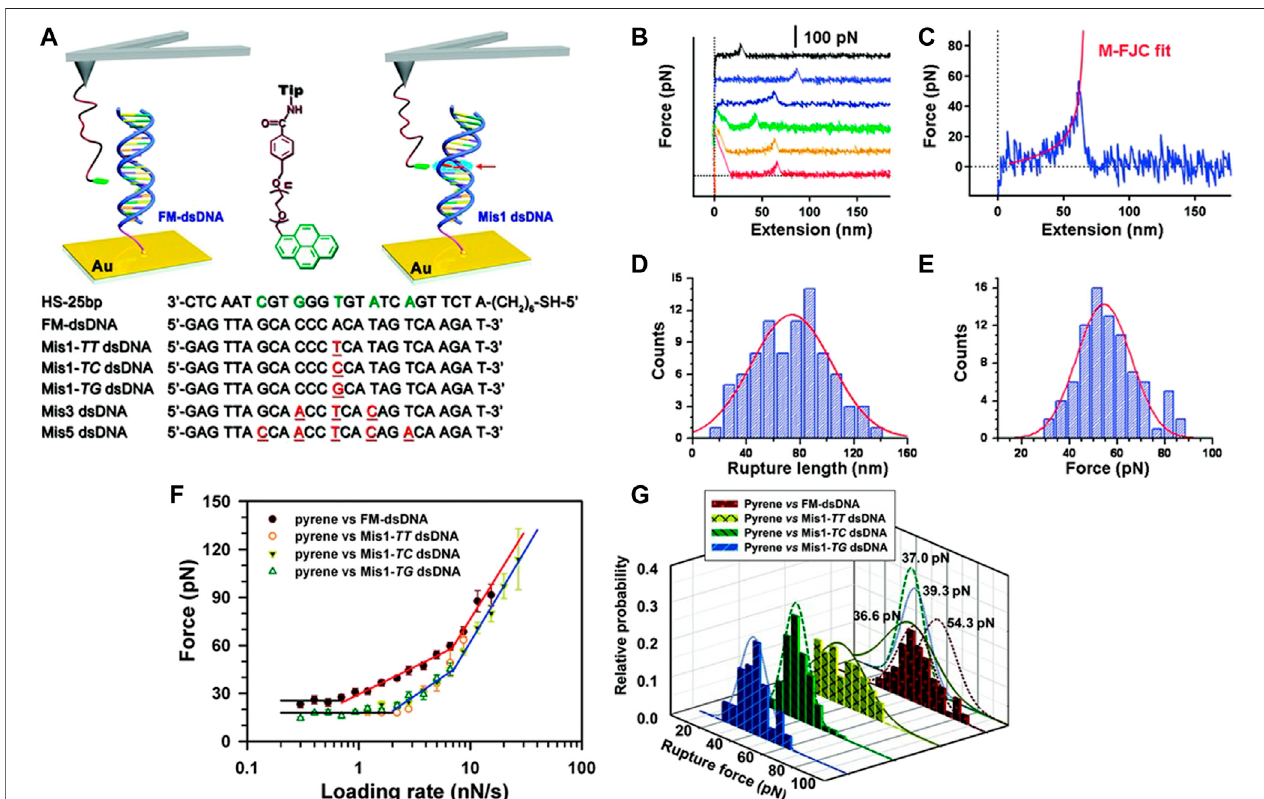
FIGURE5| (A) Schematic diagrams ofthe process ofinteractionforce measurement between dsDNA and pyrene using AFM single-molecule force spectroscopy (SMFS).Theredarrowrepresentsthemismatchedsite.Alltheoligonucleotidesequencesutilizedintheassayarementionedatthebottomtheredunderliningrepresents themismatchedbases. (B) ForcecurvesproducedwithpyrenefunctionalizedcantilevertipandFM-dsDNAfunctionalizedAusubstrateatroomtemperature. (C) M-FJC model fi ttingwasperformedwiththeforcecurve. (D) Alltherupture lengthsofforce curveswereaccumulatedtogenerateahistogramand yieldthemostprobable rupturelength as73 ( ± 30) nm. (E) The most probable rupture force wascalculated from the peak ofrupture force histogram as54.3 ( ± 12) pN. (F) Logarithm ofthe most probable rupture forces for interactions between pyrene – FM dsDNA and pyrene – Mis1 dsDNA vs. loading rates are plotted here. (G) Rupture force histograms of the interaction forces and corresponding Gaussian fi ts between pyrene and the four different types of dsDNA: Mis1 – TT dsDNA (solid), FM dsDNA (short dashed), Mis1 – TC dsDNA (dashed), and Mis1 – TG dsDNA (dotted) (Jiang et al., 2010).